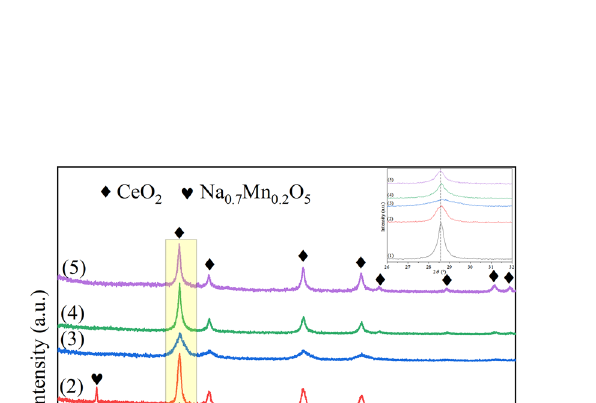
Figure 2. The stability test of the catalysts: ( a ) CM-NaC; ( b ) CM-3. (under the tight contact condition).